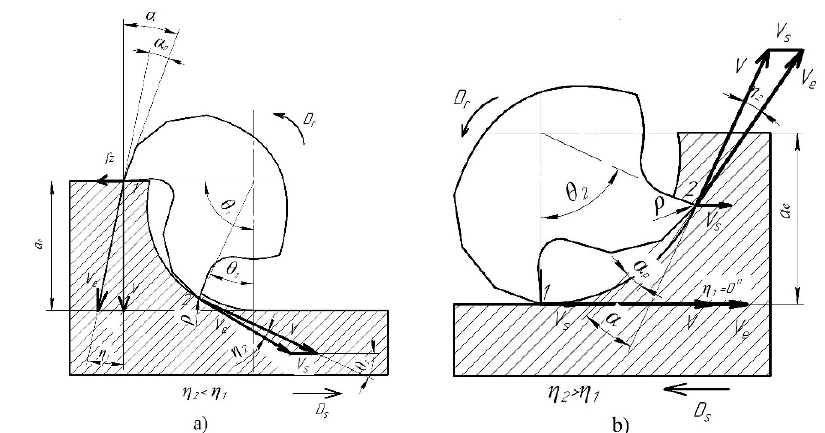
Fig. 2. Change of the angle η n the working plane at different moments of the working stroke of the mill: а – in down-milling, η 2 < η 1 , b – in up-milling, η 2 > η 1 ; 1 – the point at the moment when the cutting edge engages into the workpiece, 2 – the point engaged into the workpiece; V – the velocity of the main cutting movement at the considered cutting point; V e – the velocity of the resulting cutting speed; V s – the velocity of the feed; η – the cutting speed angle; θ 1 , θ 2 – the angles of contact of cutting tooth with the workpiece surface at the engagement and at some instance, respectively; a e – the radial depth of cut; α р – the kinematic clearance angle in the working plane; α – the clearance angle, ρ – the cutting edge rounding